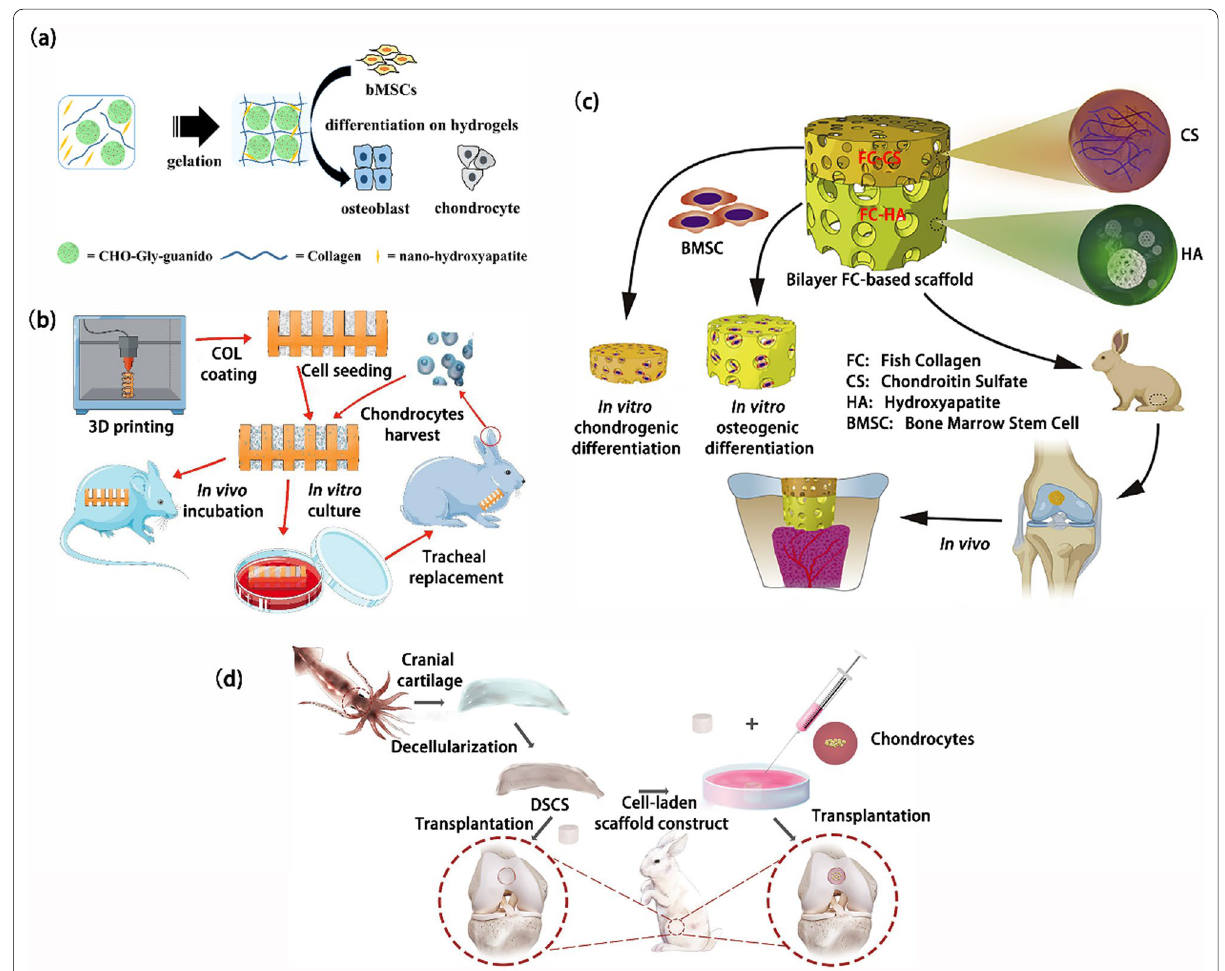
Fig. 4 Incorporation and application of collagen-based biomaterials for cartilage repair. a Collagen-nanohydroxyapatite composite hydrogel fabricated by aldehyde glycogen cross-linking. The hydrogel induced bone mesenchymal stem cells (BMSCs) differentiate into osteoblasts or chondrocytes. (Adapted from ref. [90], copyright 2020, with permission from ACS Publications.) b Collagen embedded scaffold fabricated with 3D printing. The biomimetic scaffold recolonized by chondrocytes elicited a satisfactory repair outcome for cartilage replacement both in vitro and in vivo. (Adapted from ref. [83], copyright 2021, with permission from Frontiers Media S.A.) c Bilayer collagen-based scaffold with varied pore sizes and crucial components. The bottom layer with larger pores and hydroxyapatite as well as the top layer with small pores and chondroitin sulfate were established to mimic the morphology of cartilage and bone tissue. (Adapted from ref. [60], copyright 2020, with permission from Elsevier.) d Decellularized cartilage tissue laden with chondrocytes as a biomimetic implantation. Cartilage tissue maintained critical structure and component of the extracellular matrix to the maximum extent. (Adapted from ref. [44], copyright 2020, with permission from the Royal Society of